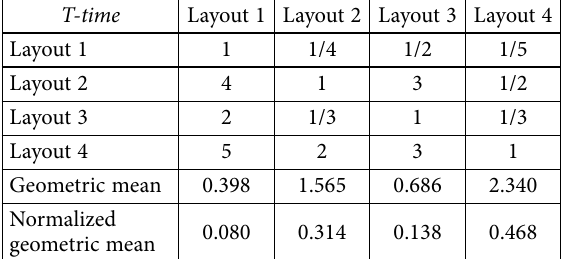
Table 5. The comparison matrix of the layouts for loading units’ transhipment time (T-time)